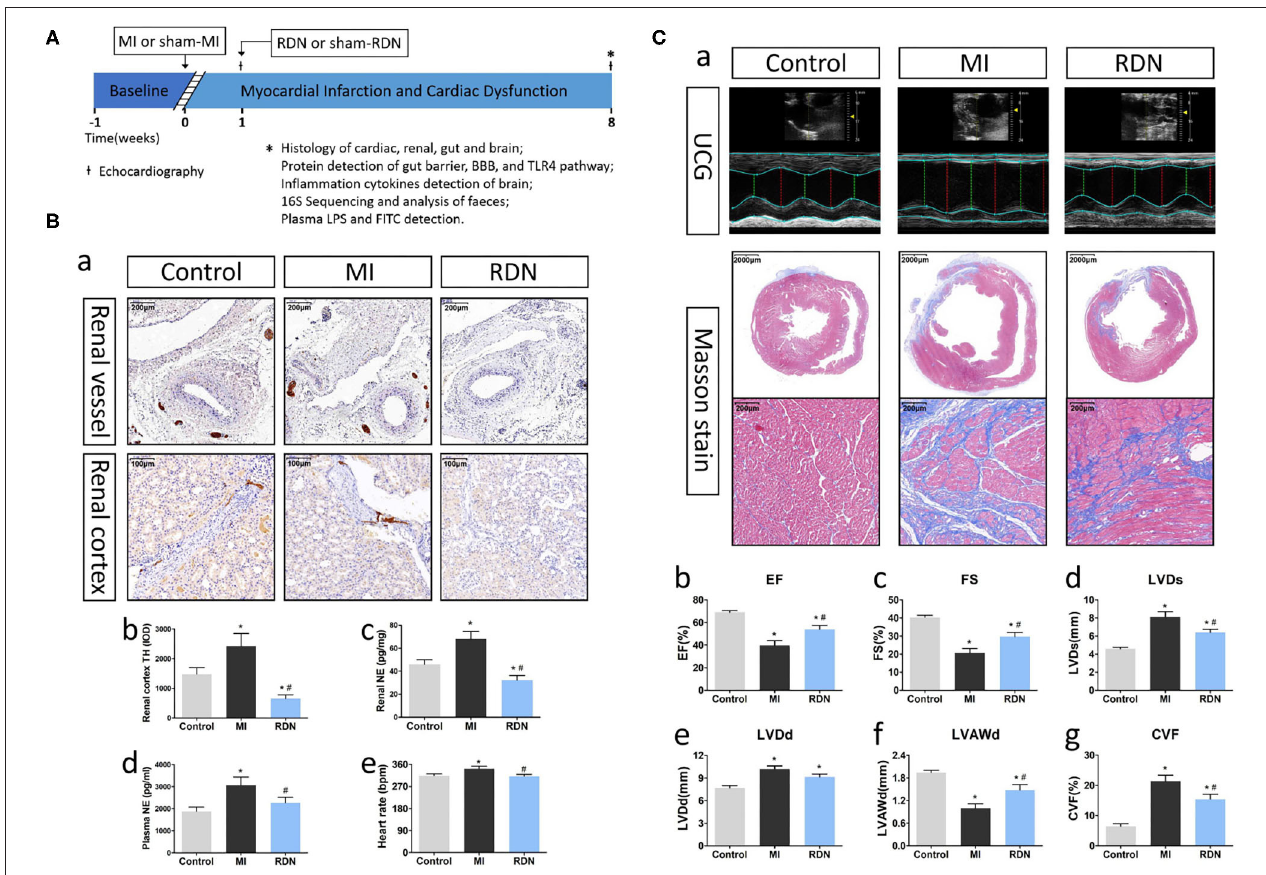
FIGURE 1 | RDN removes renal sympathetic nerve and ameliorates cardiac function in MI rats. (A) A schematic diagram illustrates the experimental protocol. (B) RDN significantly decreases renal sympathetic nerve activity. (a) Representative images of anti-TH immunohistochemical staining in the renal vessel (magnification, 100 × ) and renal cortex (magnification, 200 × ) of rats. (b) Quantitative analysis of TH-positive regions in the renal cortex. (c) ELISA analysis of renal NE levels. (d) ELISA analysis of plasma NE levels. (e) Heart rate of rats from each group. (C) RDN ameliorates the MI-induced myocardiac dysfunction. (a). Echocardiography and Masson’s trichrome staining (magnification, 10 × and 200 × ) were performed to evaluate myocardial fibrosis and cardiac function in rats. (b) EF; (c) FS; (d) LVDs; (e) LVDd; (f) LVAWd; (g) CVF. * P < 0.05 vs. the Control group; # P < 0.05 vs. the MI group. EF, ejection fraction; FS, fractional shortening; LVDs, left ventricular end systolic diameter; LVDd, left ventricular end diastolic diameter; LVAWd, left ventricular anterior wall diastolic thickness; CVF, collagen volume